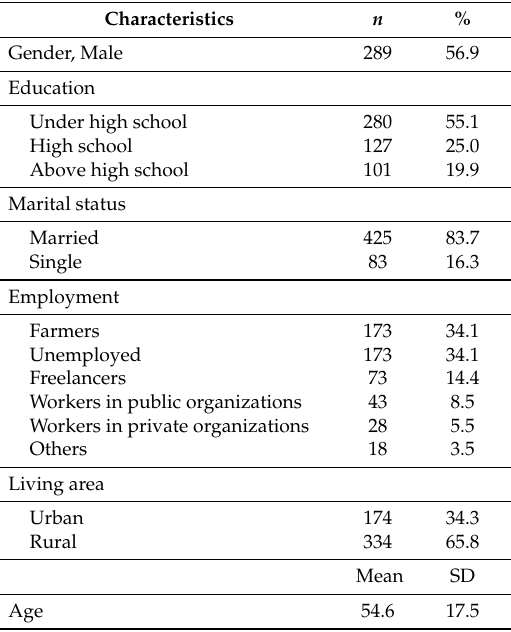
Table 1. Socio-economic characteristics of respondents ( n = 508).